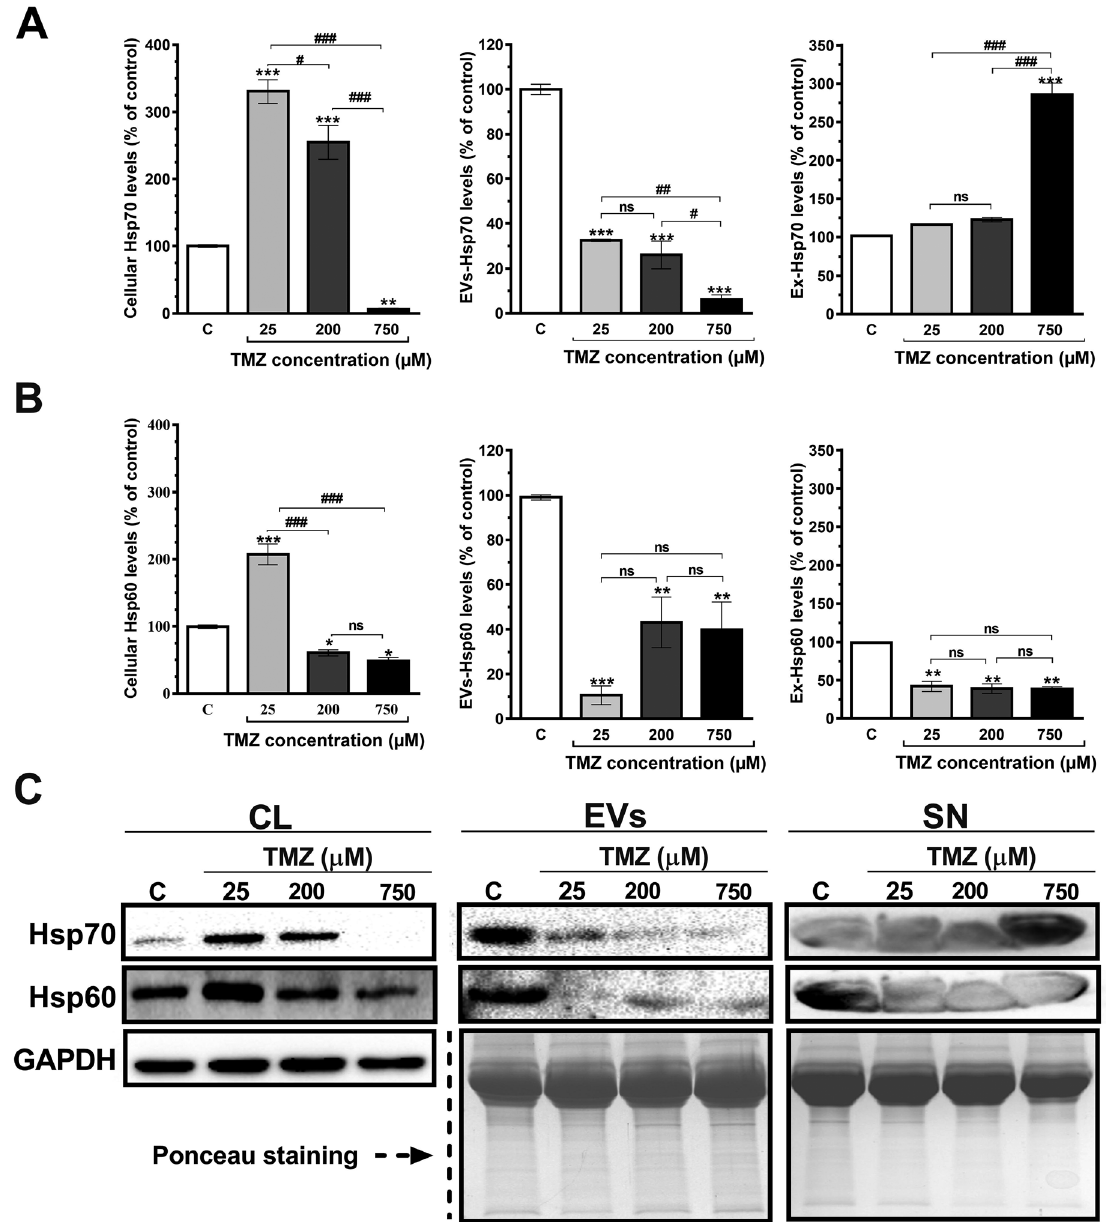
Figure 4: The effects of temozolomide (TMZ) treatment on expression of Hsp70 and Hsp60. A) The expression levels of cellular, EV-derived, and extracellular (Ex) Hsp70 in dose dependent manner. B) The expression levels of cellular, EV-derived, and extracellular (Ex) Hsp60 in dose dependent manner. C) Western blotting analysis of Hsp70 and Hsp60 expression in cell lysate (CL), extracellular vesicles (EVs), and supernatant-cell media (SN). While using GAPDH as a loading control for CL, Ponceau staining was performed for SN and EVs. p-Values were determined using one-way ANOVA followed by Tukey ’ s post hoc test. *p<0.05, **p<0.01, and ***p<0.001 vs. control (C) group. #p<0.05, ##p<0.01, and ###p<0.001 indicate statistical difference between different groups. Vertical bars indicate standard deviation